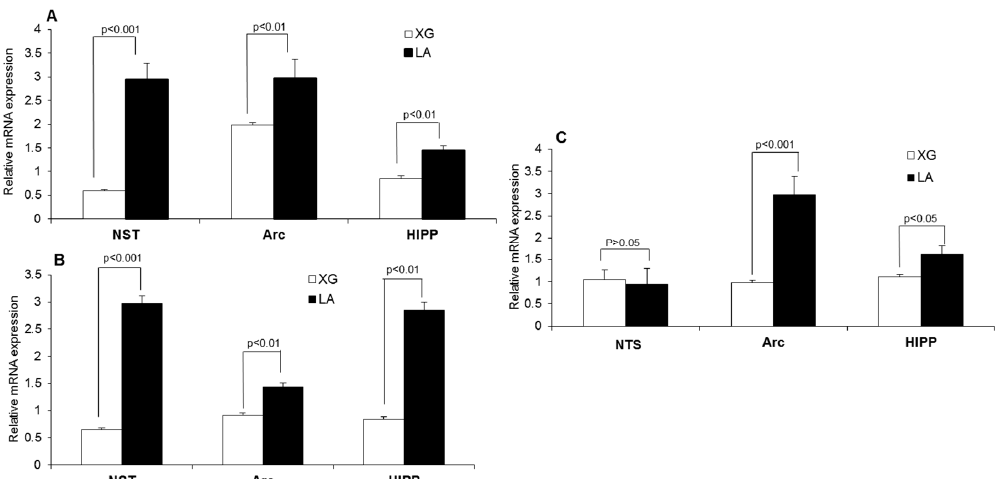
Figure 3. Lingual application of LA modulates brain-derived neurotrophic factor (BDNF), Zif-268, and Glut-1 mRNA expression in the mouse brain. Bar graphs represent the relative increase in mRNA expression (Zif-268 in ( A ), Glut-1 in ( B ), BDNF in ( C )) in mice subjected to oral stimulation with linoleic acid (LA) or xanthan gum as control solution. Values are means ± SEM; n = 6; for each structure studied, treatment effects on Zif-268 and Glut-1 mRNA expression were assessed using unpaired one-sided t -tests. NST, nucleus of solitary tract; Arc, arcuate nucleus; Hipp, hippocampus.